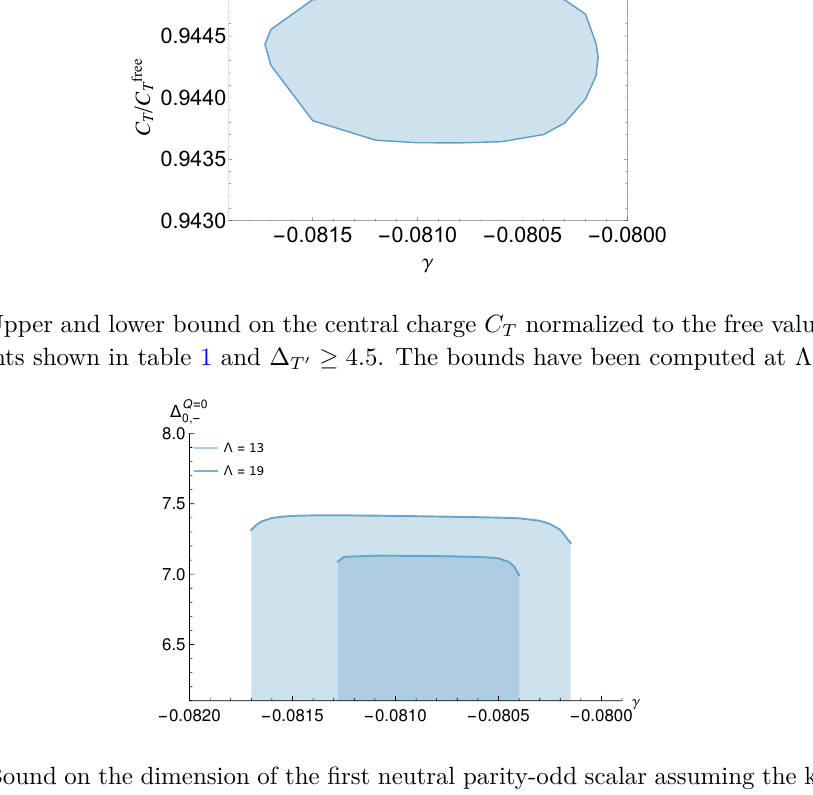
Figure 4 . Bound on the dimension of the first neutral parity-odd scalar assuming the known O (2) constraints shown in table 1 and ∆ T 0 ≥ 4 . 5 . The bounds terminate because γ is confined in an interval, see figure